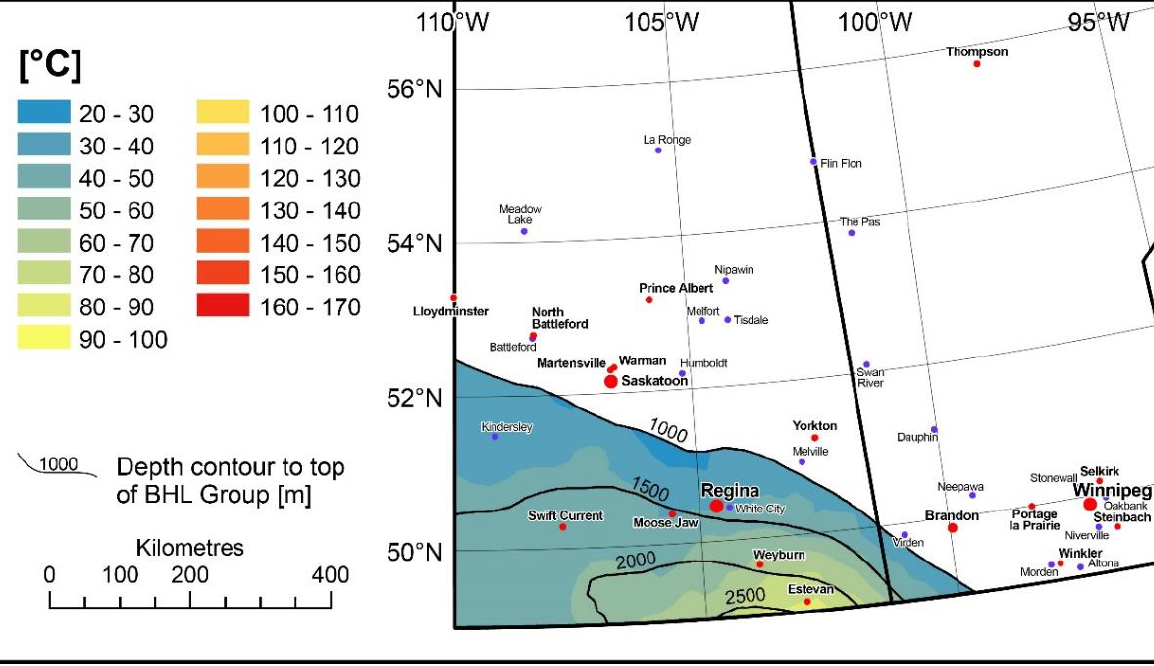
Figure A3. Temperatures top of BHL Group—Saskatchewan – Manitoba WCSB.